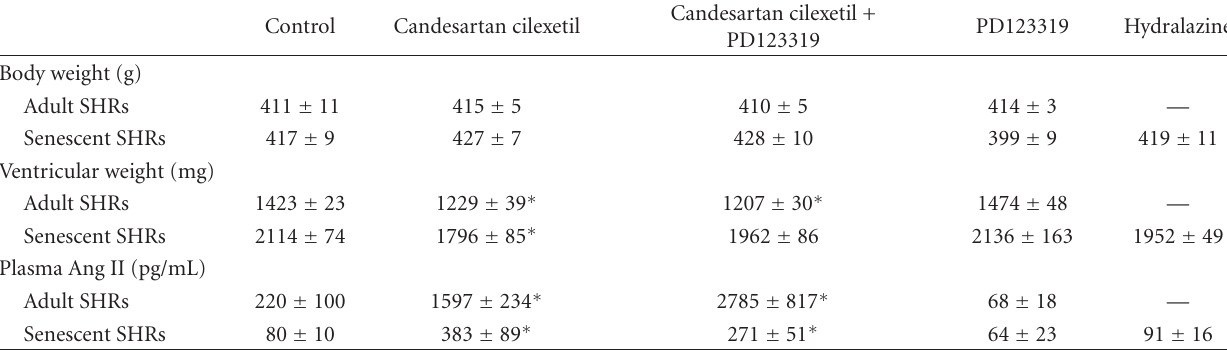
Table 1: E ff ect of drug treatments on body weight, ventricular weight, and plasma Ang II of adult and senescent SHRs. Candesartan cilexetil + Control Candesartan cilexetil PD123319 Hydralazine PD123319 Body weight (g) Adult SHRs 411 ± 11 415 ± 5 410 ± 5 414 ± 3 Senescent SHRs 417 ± 9 427 ± 7 428 ± 10 419 ± 11 Ventricular weight (mg) Adult SHRs 1423 ± 23 1229 ± 39 ∗ 1207 ± 30 ∗ Senescent